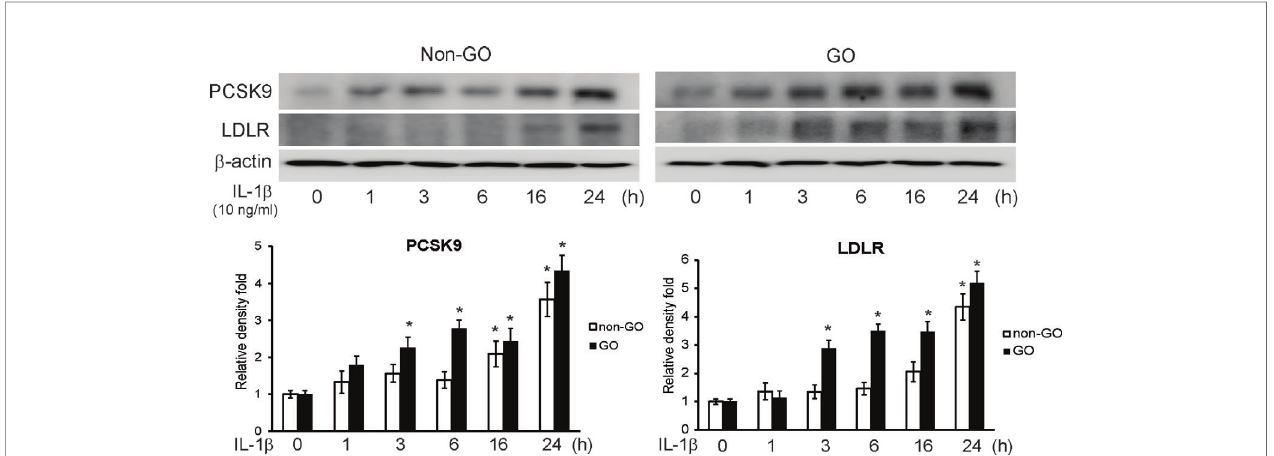
FIGURE 2 | Western blot of proprotein convertase subtilisin/kexin type 9 (PCSK9) and low density lipoprotein receptor (LDLR) after interleukin-1 b (IL-1 b ) treatment. Con fl uent orbital fi broblasts obtained from Graves ’ orbitopathy (GO) (n=3) and non-GO subjects (n=3) were treated with 10 ng/ml of IL-1 b for increasing lengths of time (0 – 24 h). Western blot analyses were performed to investigate the levels of PCSK9 and LDLR. The treatment with IL-1 b increased the levels of PCSK9 and LDLR in both GO and non-GO tissues in a time-dependent manner. Representative gel images are shown. Data in the columns indicate the mean density ratio ± SD, normalized to the level of b -actin in the same sample (* p < 0.05 vs. 0 h in each